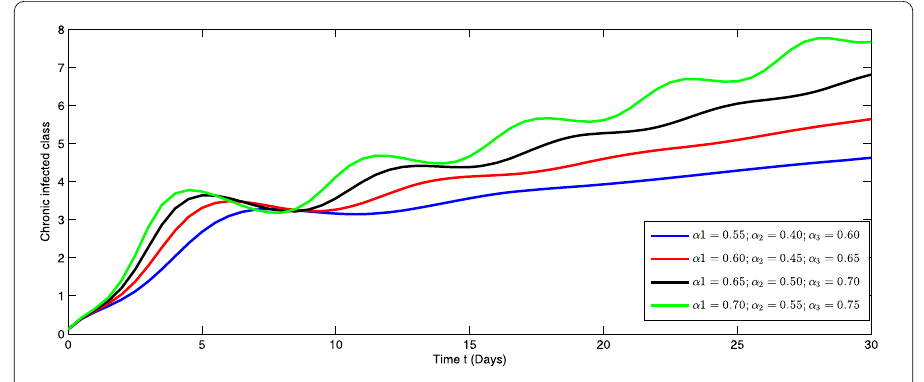
Figure 8 Dynamical behavior of C for different values of α i ( i = 1,2,3) at integer order